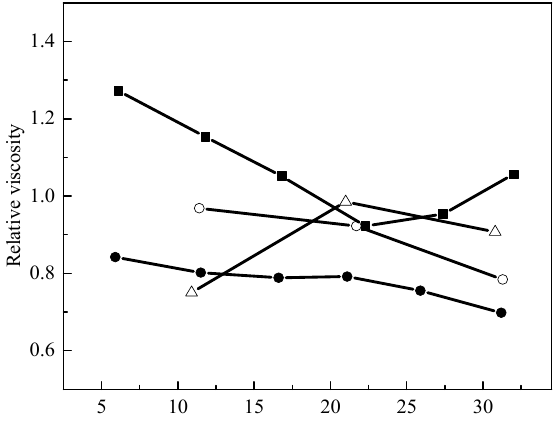
Figure 9. Relative viscosities of hydrate slurries (equilibrium slurry viscosities divided by viscosity of gas-free water-in-oil emulsions with the same temperature and water cut) for ( △ ) 276.2 K with AA-1-, ( ○ ) 276.2 K & ( ● ) 278.2 K with AA-2- and ( ■ ) 278.2 K, with AA-3-contained systems with an initial pressure of 6.0 MPa, a stirring speed of 300 rpm and a water cut from 5% to 30%. Lines are provided to guide the eye.